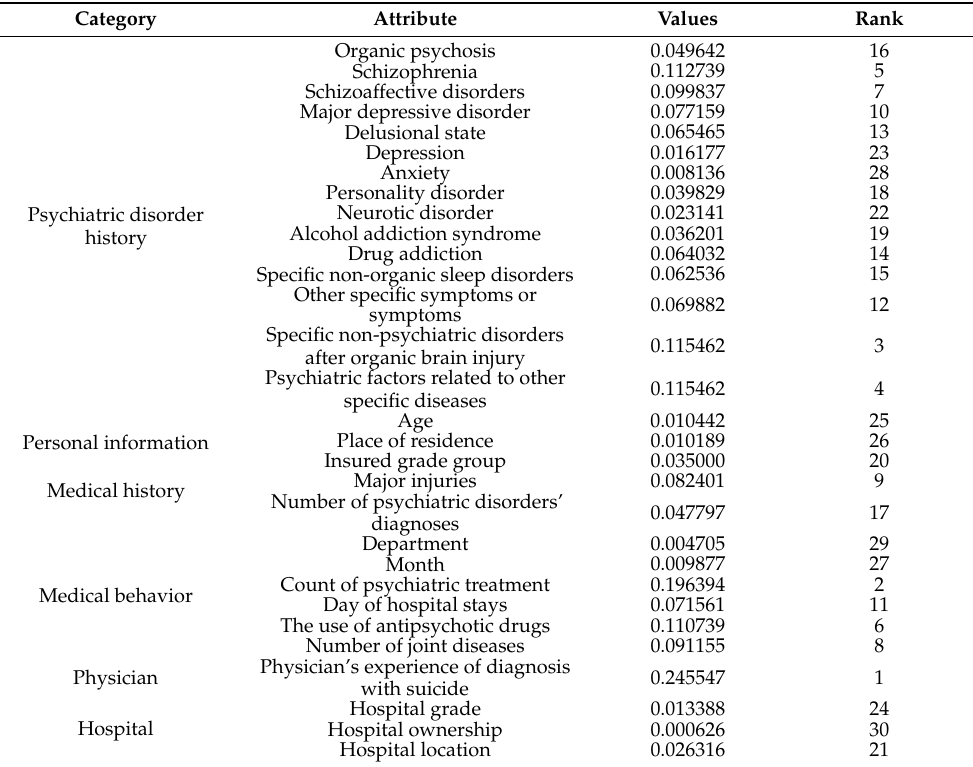
Table 4. The importance of investigated independent